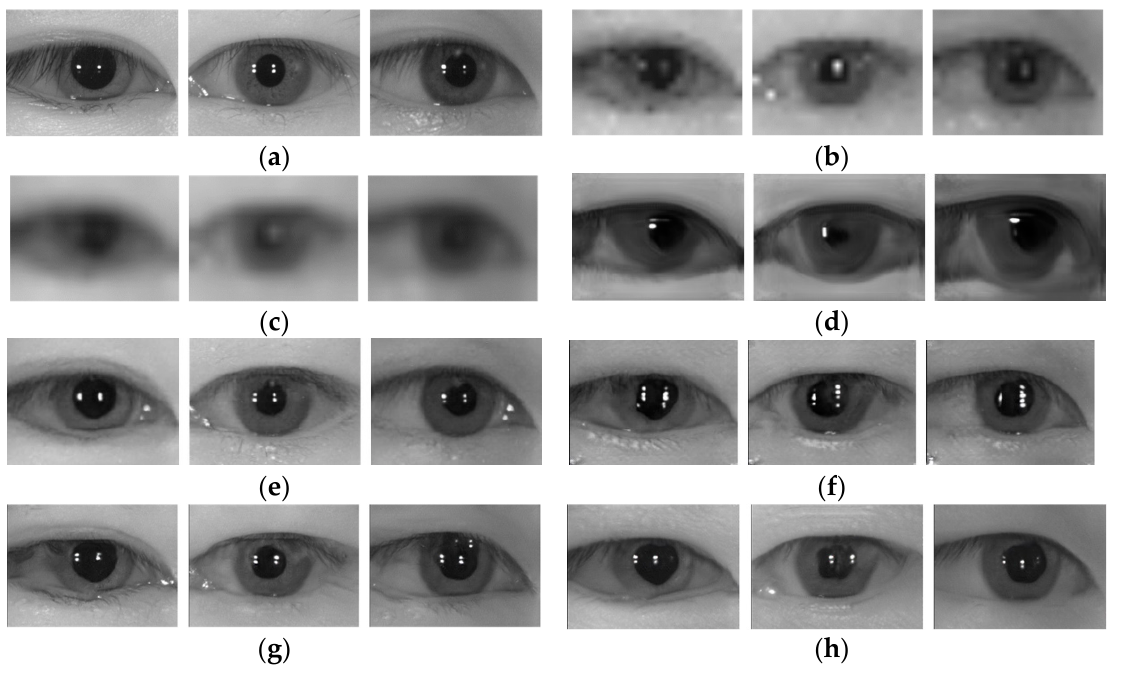
Figure 5. Comparisons on SRR by the proposed method and the state-of-the-art methods. ( a ) Original high-resolution images. ( b ) Low-resolution images by bilinear interpolation. ( c ) Low-resolution images by bilinear interpolation + Gaussian blurring. ( d ) Output images by SRGAN with ( c ). ( e ) Output images by Pix2Pix with ( c ). ( f ) Output images by CycleGAN with ( c ). ( g ) Output images by OSRCycleGAN with ( b ). ( h ) Output images by OSRCycleGAN with ( c ).